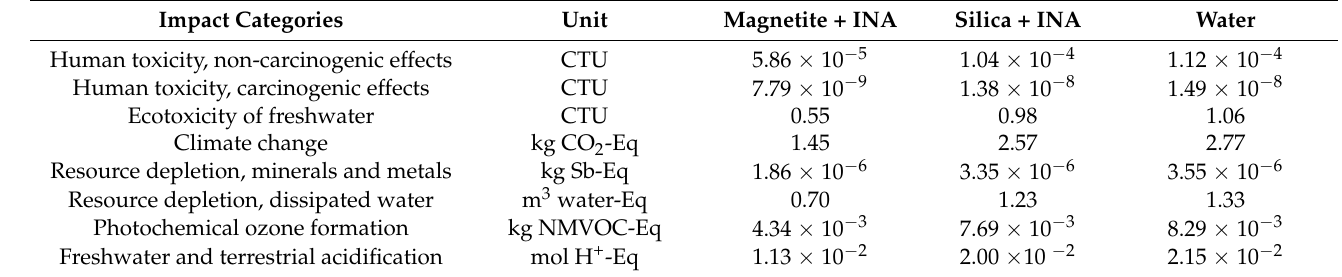
Figure 4. Environmental impacts of the magnetite + INA bionanocompound, the silica + INA bi- onanocompound, and water on climate change. Table 2. Total impact assessment results for bionanocompounds and water, including the manufac- turing and operation